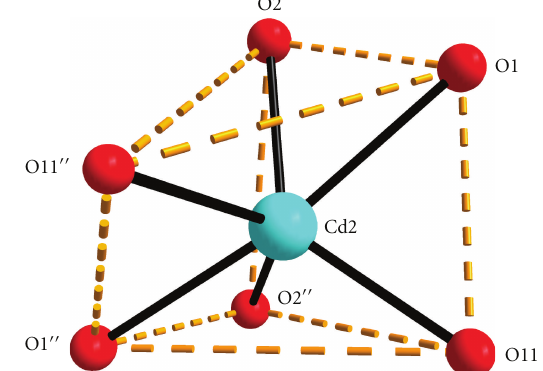
Figure 2: The distorted trigonal prismatic geometry of Cd(2) in complex 1 . Double primes are used for symmetry-related atoms (see footnote of Table 2).